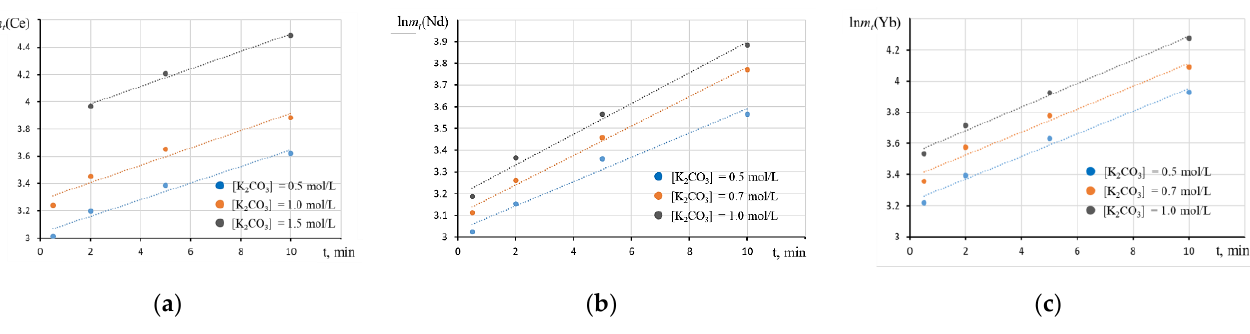
Table 7. Empirical dependence of the degree of recovery into the solution on the concentration of